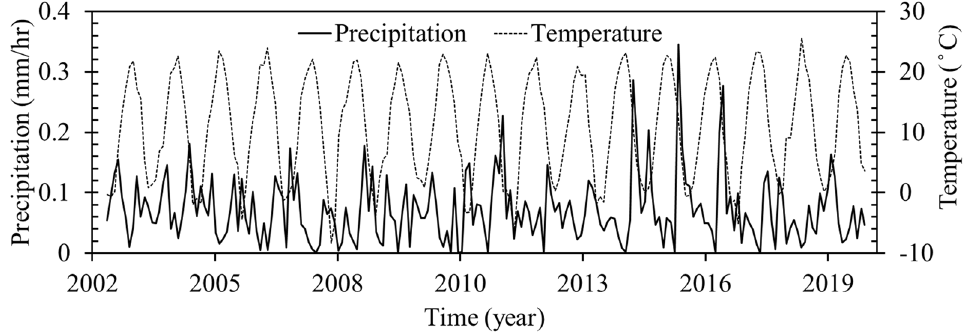
Figure 2. Total precipitation from (2000–2020) based on the TRMM rainfall estimate month data, and annual temperature rate from (2002–2020) based on the FLDAS datasets (https:// das. gsfc. nasa. gov/ fldas).